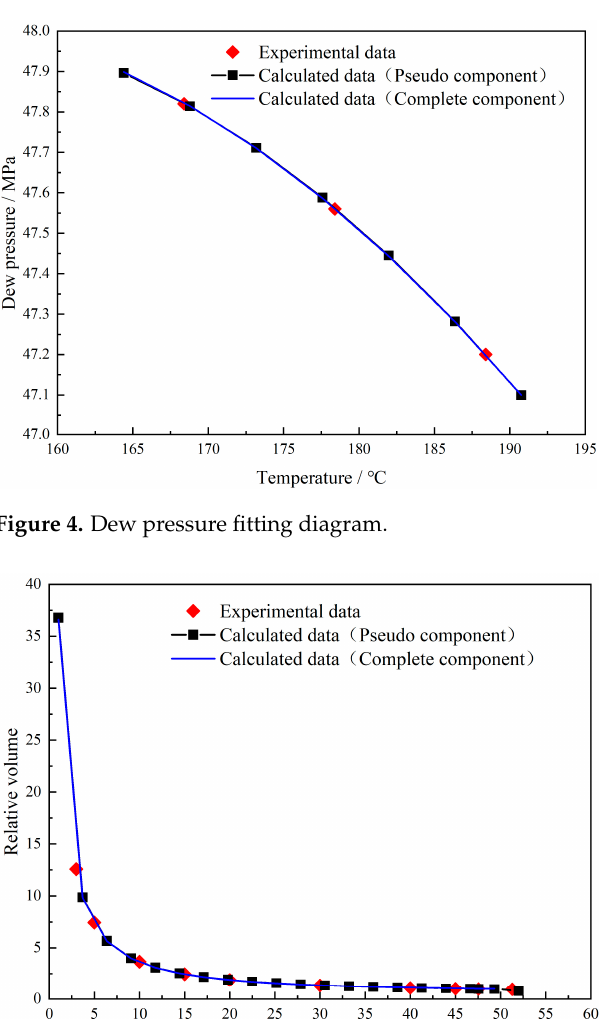
Figure 3. P-T phase diagram of formation fluid.